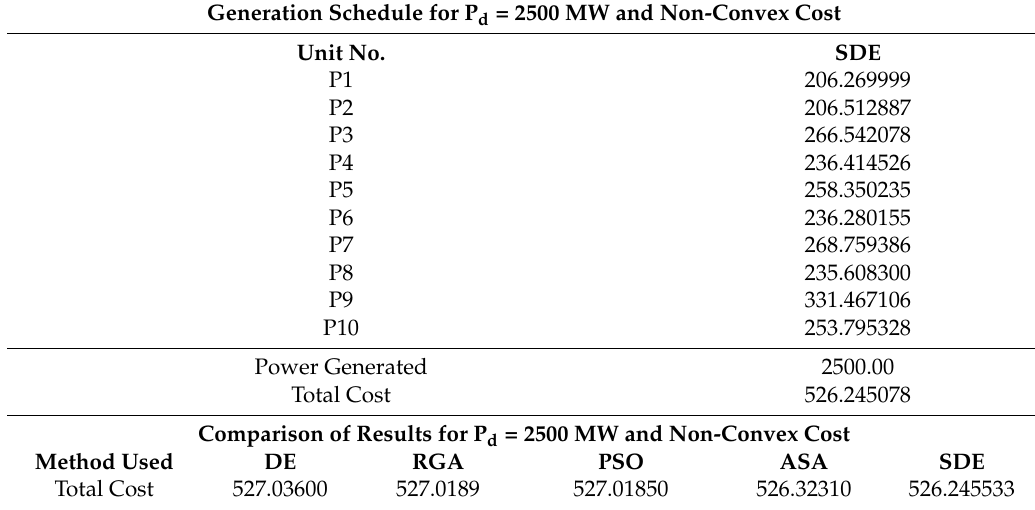
Table 8. Cost comparison among various methodologies for System 2, P d = 2500 MW. Generation Schedule for P d = 2500 MW and Non-Convex Cost